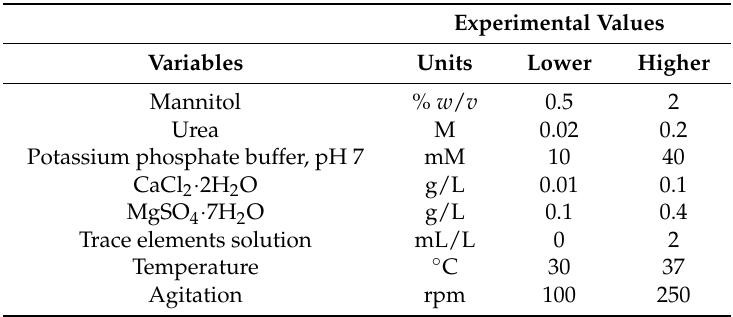
Table 1. Maximum and minimum values of the variables used for the production of rhamnolipids by B. glumae BGR1 using FFD.